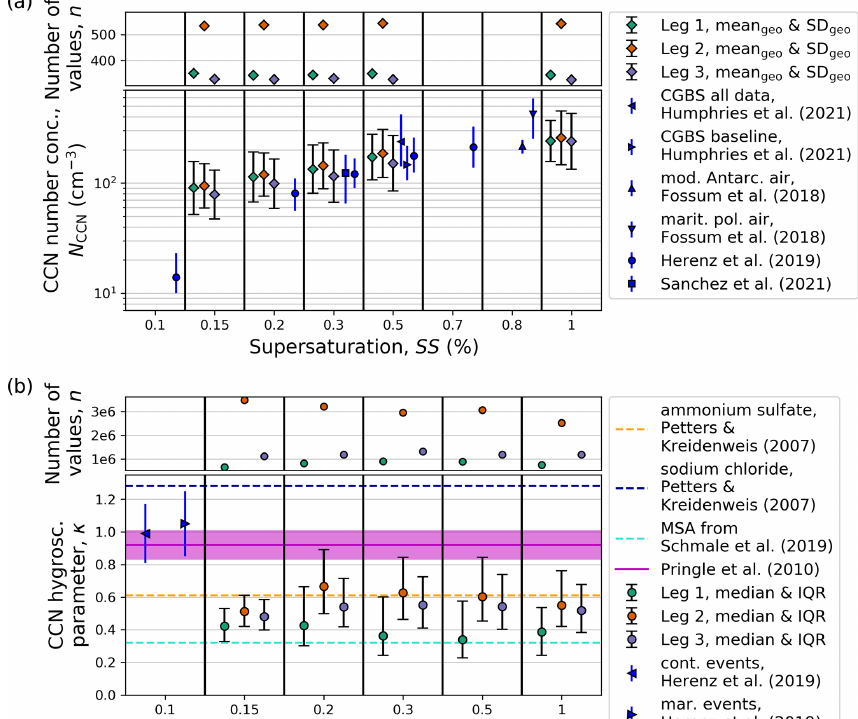
Figure 3. (a) Geometric mean values (mean geo ) and geometric standard deviation (SD geo ; whiskers) of CCN number concentration ( N CCN ) and (b) median values and respective inter-quartile range (IQR) of aerosol particle hygroscopicity parameter ( κ ). Both N CCN and κ are given as function of supersaturation (SS) for Leg 1 (green), Leg 2 (orange), and Leg 3 (purple), respectively. All κ values resulting from D crit values outside of 10th to 90th percentile range for D crit (per SS) are excluded here. Included for comparison in (a) are the averages (median and IQR) over all measurements at Cape Grim Baseline Station (CGBS) coinciding with PEGASO and CAPRICORN-II from Humphries et al. (2021) (triangle pointing left) and measurements for “baseline” conditions (triangle pointing right) during that period. Baseline conditions are defined as wind directions between 190 and 280 ◦ , and ambient radon concentrations below 100mBqm − 3 . Averages for events of modified Antarctic air (upward pointing triangle) and maritime polar air (downward pointing triangle) from Fossum et al. (2018) are given. As reference, mean κ values for sodium chloride (dashed blue line) and ammonium sulfate (dashed orange line) from Petters and Kreidenweis (2007), and a hypothetical κ value for MSA from Schmale et al. (2019) (dashed teal line) is given in (b) . Averages for Antarctica from Herenz et al. (2019) for cases of continental (triangle pointing left) and marine events (triangle pointing right) are given. Modelled κ values for the Southern Ocean’s surface layer (magenta line and area) from Pringle et al. (2010) for reference. The number of data points ( n ) are indicated in the